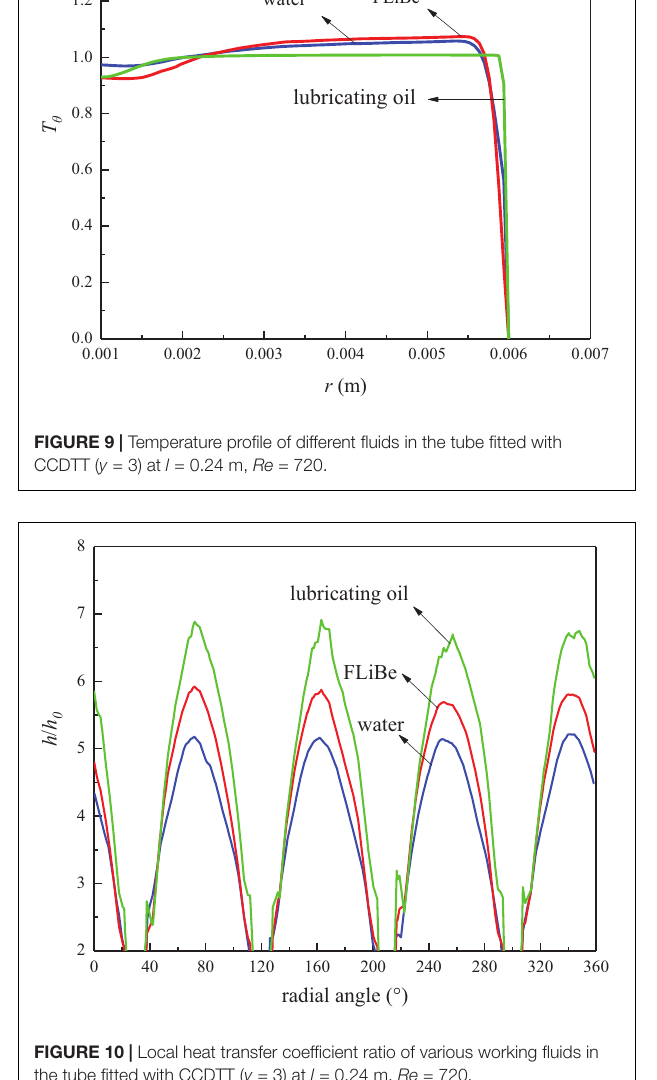
level for various working fluids at the laminar regime. This